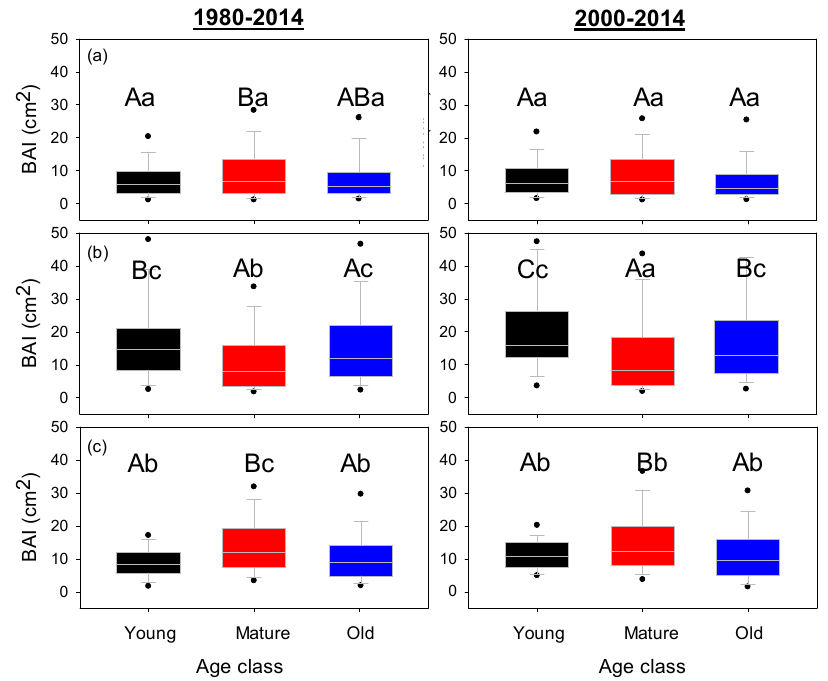
Figure 5. Difference of the basal area increment (BAI) of N. macrocarpa populations among clusters